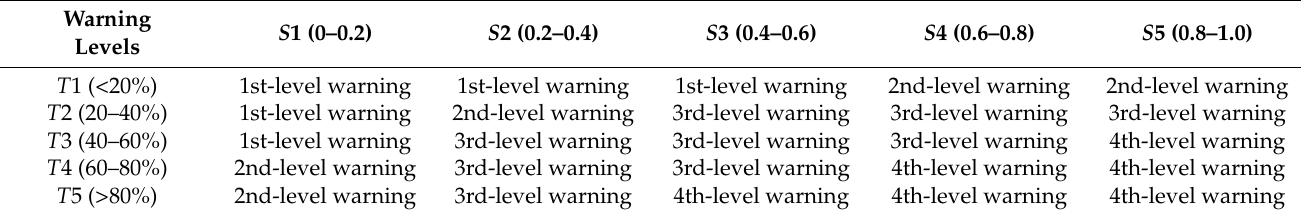
Figure 14. Statistics of the frequency of historical landslides and the conversion method from the landslide forecast model to warning levels: ( a ) DLEWM and ( b ) PLEWM. Table 3. Discriminant matrix determined by the frequency